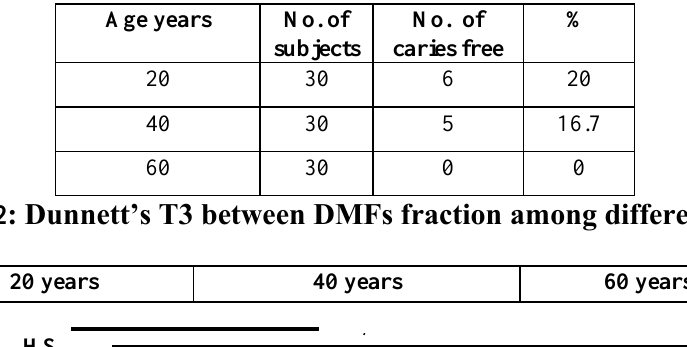
Table 1: Distribution of caries free among subjects by ages